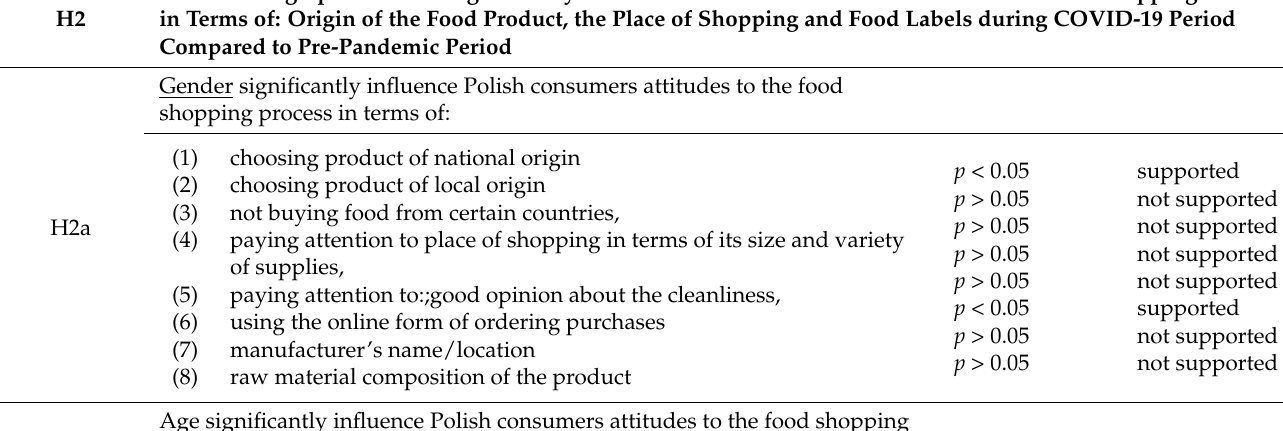
Table 12. Verification of the Hypothesis